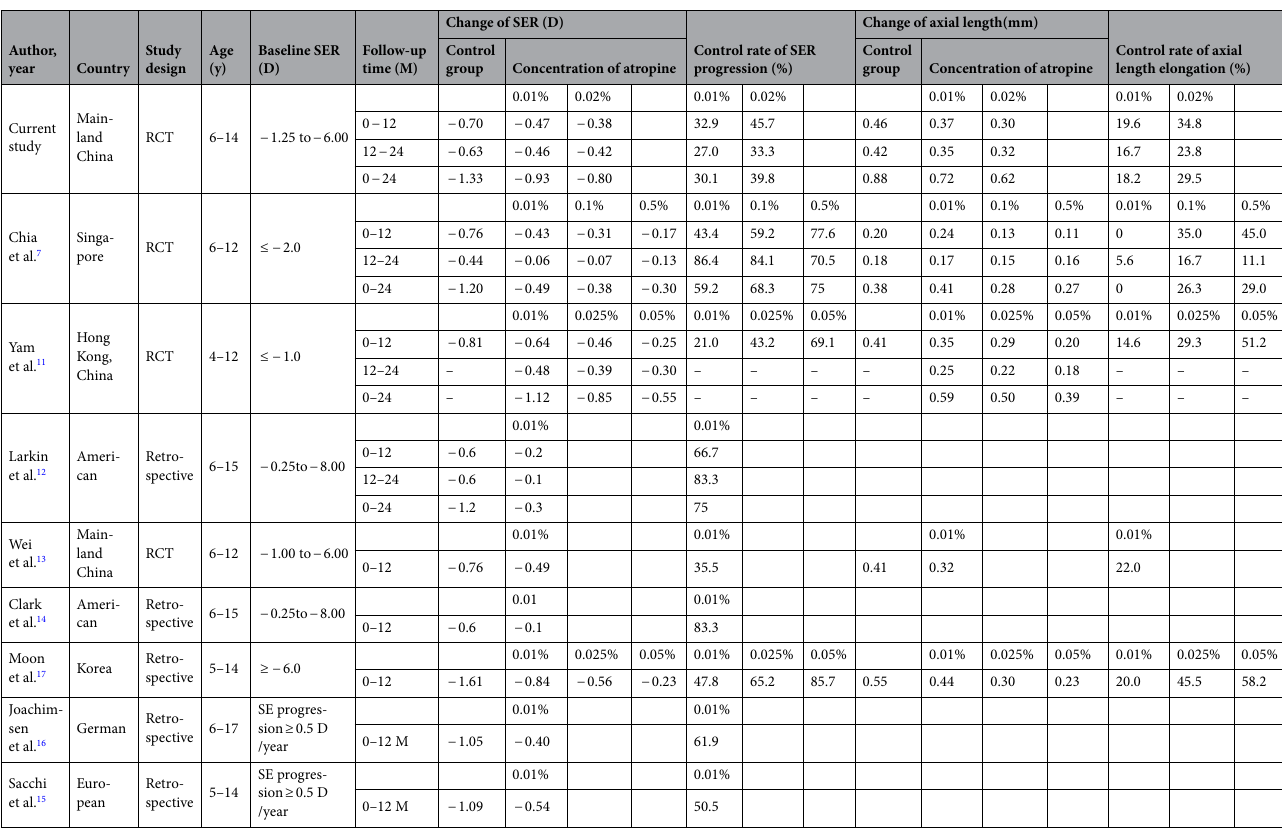
Table 4. Control rate of spherical equivalent refractive error (SER) progression and axial length elongation on myopia children using atropine in different